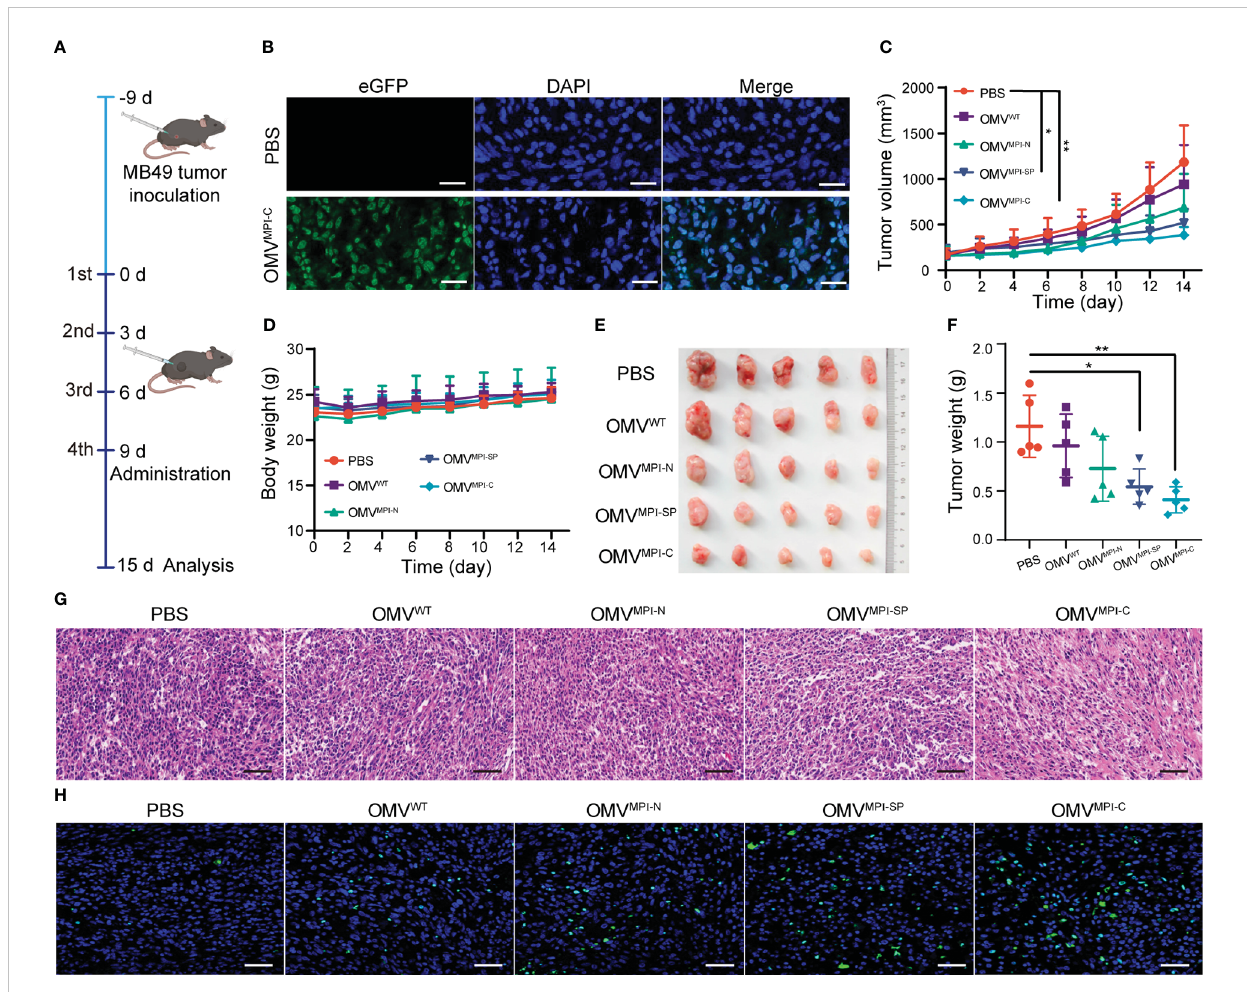
FIGURE 3 Investigation of bioengineered OMVs for BCa treatment in vivo . (A) The diagrammatic sketch of experimental design for evaluating BCa inhibition effectiveness of bioengineered OMVs using subcutaneous tumor-bearing mice. (B) Fluorescence images of tumor slice after intratumoral injection of PBS and OMV MPI-C solutions. Cell nuclei were stained with DAPI (blue). Scale bar = 50 m m. Subcutaneous tumor volumes (C) and body weights (D) of tumor-bearing mice recorded every other day from day 0 to day 15 ( n = 5). Image (E) and corresponding weights (F) of tumors harvested from tumor-bearing mice at the end of the treatments ( n = 5). H&E staining (G) and fl uorescence TUNEL staining images (H) of tumor tissue at the end of the treatments. Scale bars = 50 m m. Data in (C, D, F) are presented as mean ± SD. Statistical signi fi cance was calculated via one-way ANOVA with a Tukey ’ s post-hoc test. * p < 0.05, ** p <